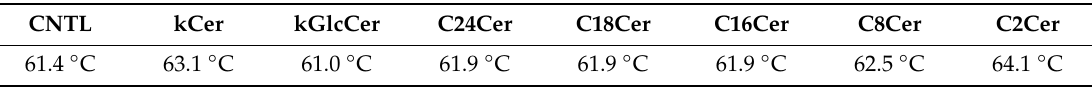
Table 1. Di ff erential scanning calorimetry (DSC) analysis of potential interactions between BSA (3 mg / mL) and ceramides (100 µ M). CNTL